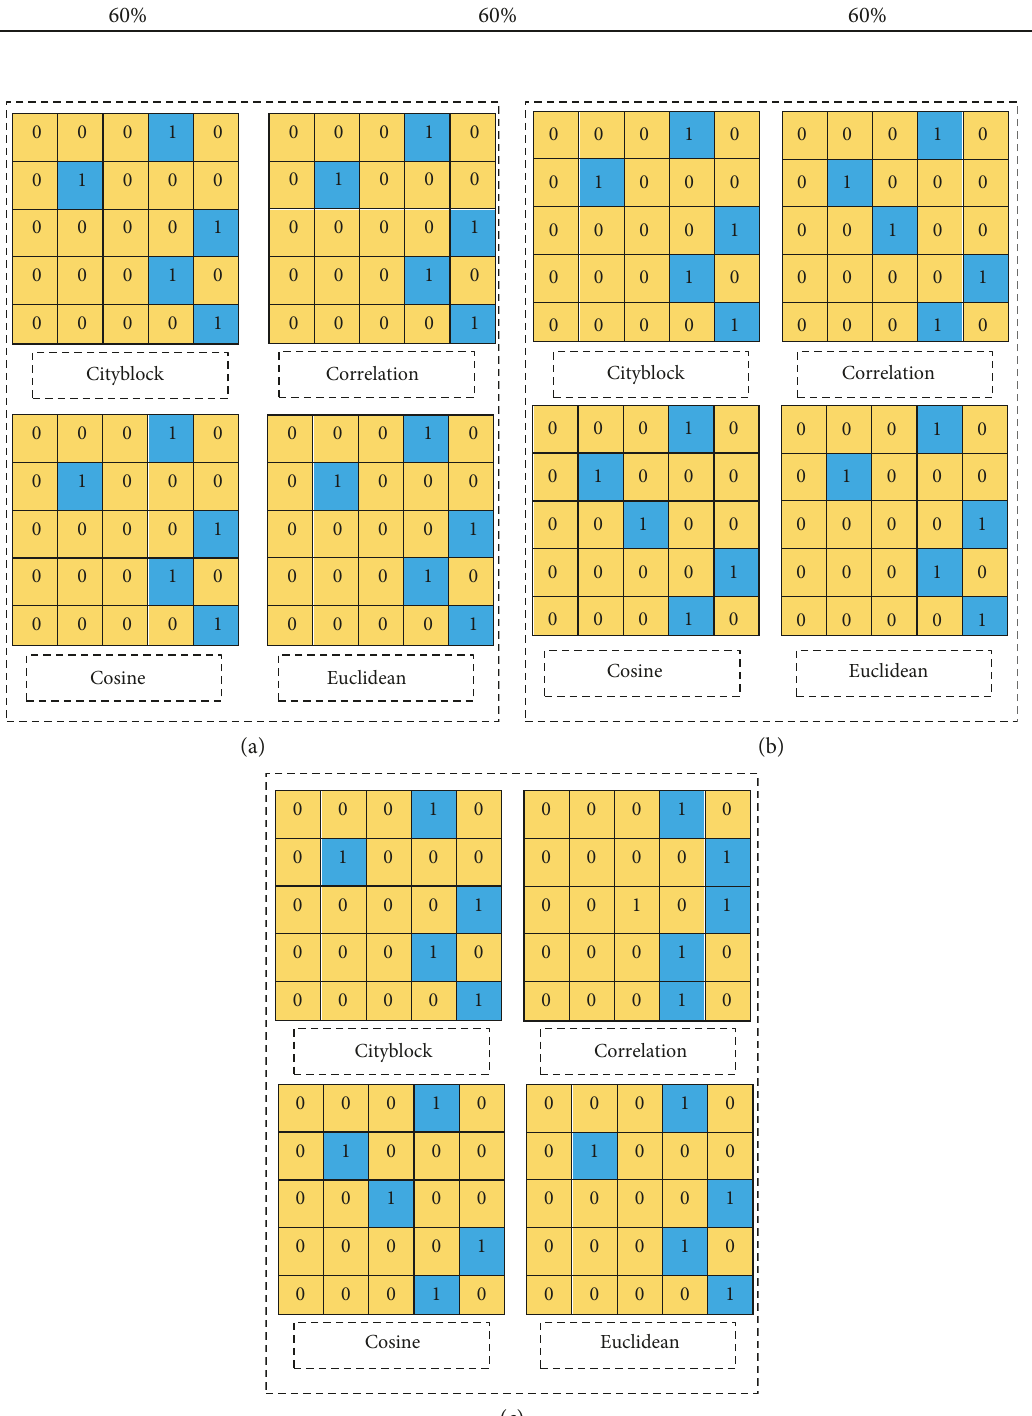
Table 3: Percentage of accuracy due to variation of classi fi cation rule other parameters kept constant. Distance types “ Correlation ”